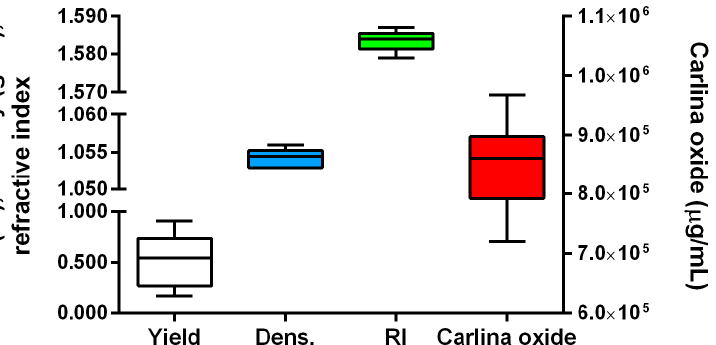
Figure 1. Box plots displaying values distribution of yield (%), density, refractive index (RI), and carlina oxide content (µg/mL). The horizontal line within the box is the median value, while the maximum and minimum values recorded are represented by the whiskers.